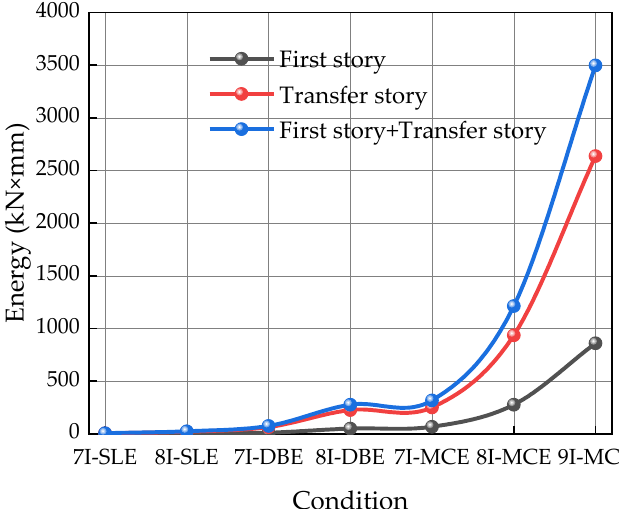
Figure 23. Energy-loading condition curve.